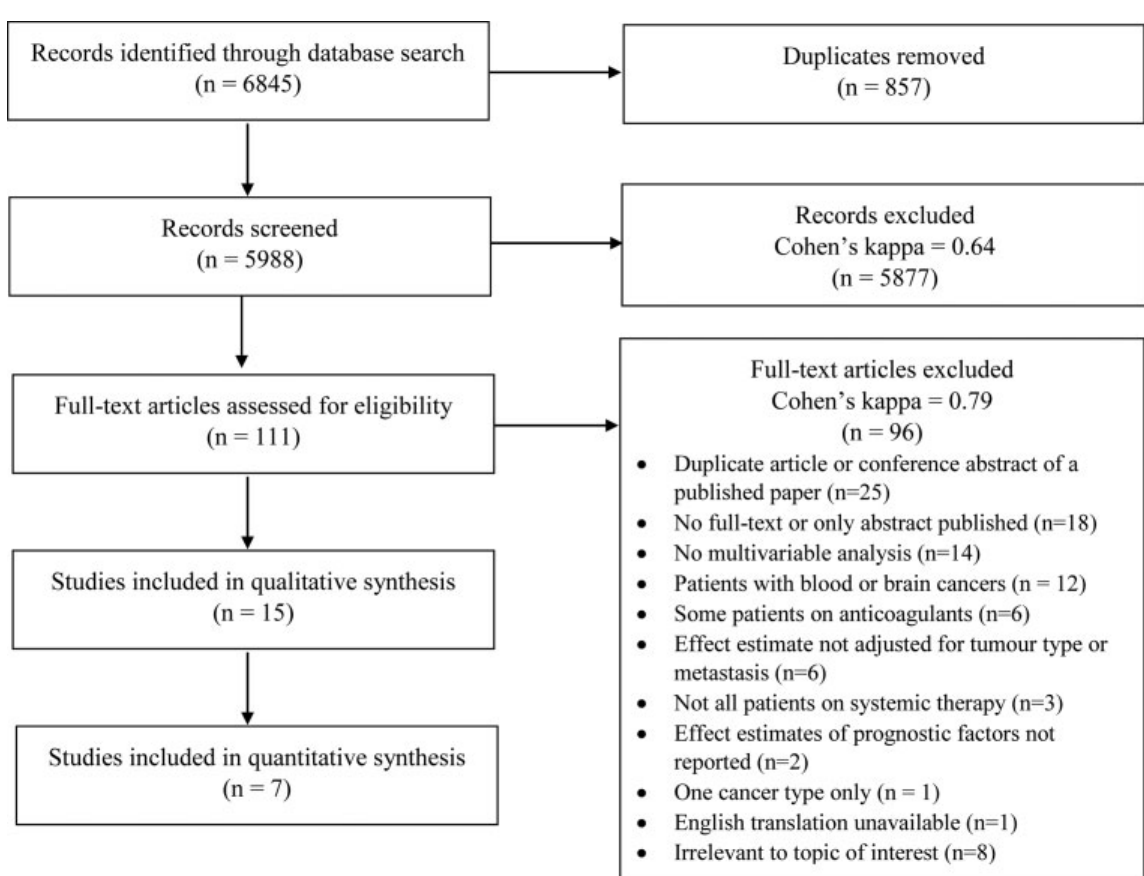
Fig. 1 Flow diagram of study